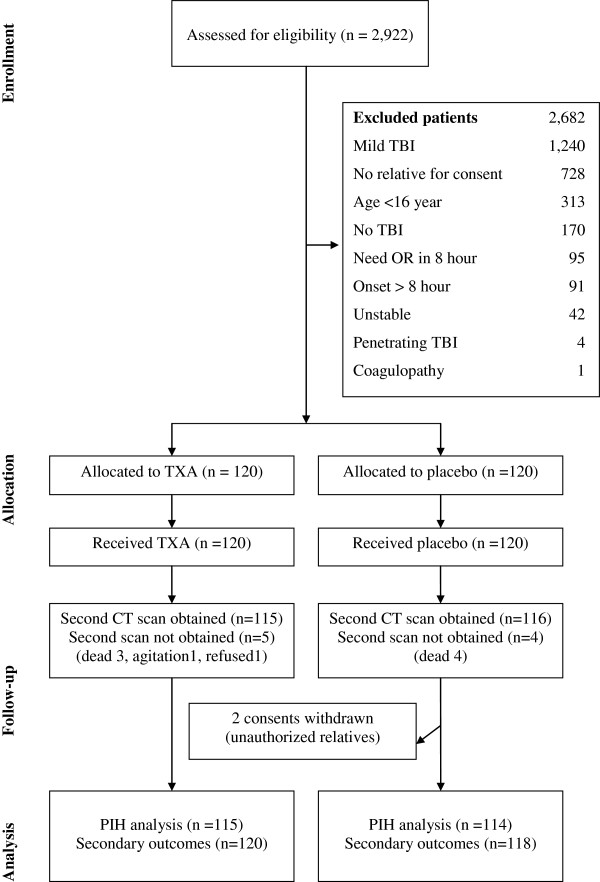
Participant flow.